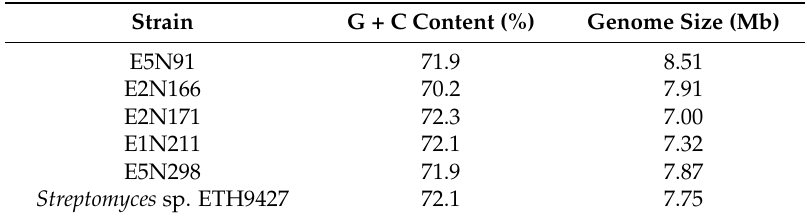
Table 1. Strains analyzed in this